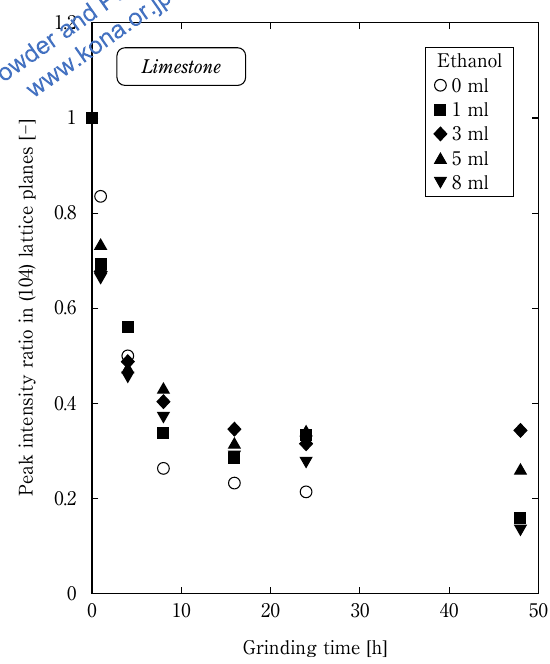
Fig. 8 Plots of peak intensity ratio in (104) lattice plane vs. grinding